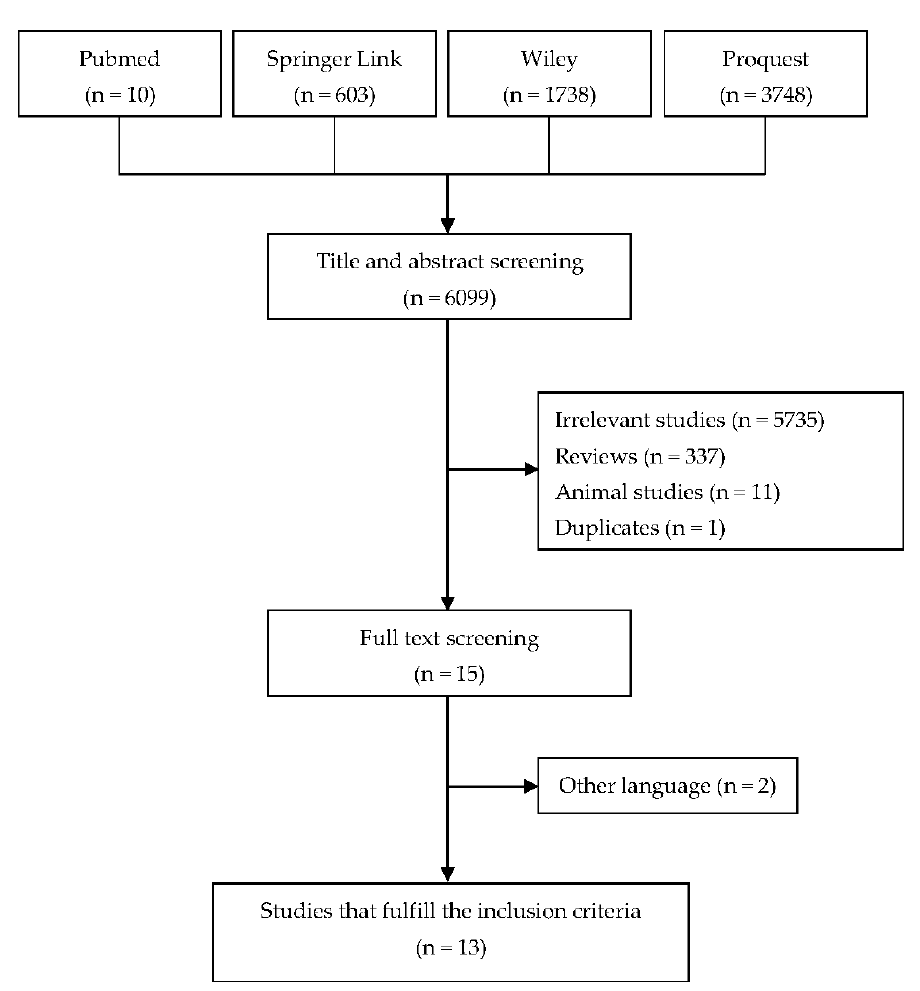
Figure 1. Flowchart for inclusion and exclusion. Table 2. Study characteristics of expression level and concentration of PD-1 protein in septic pa- tients.